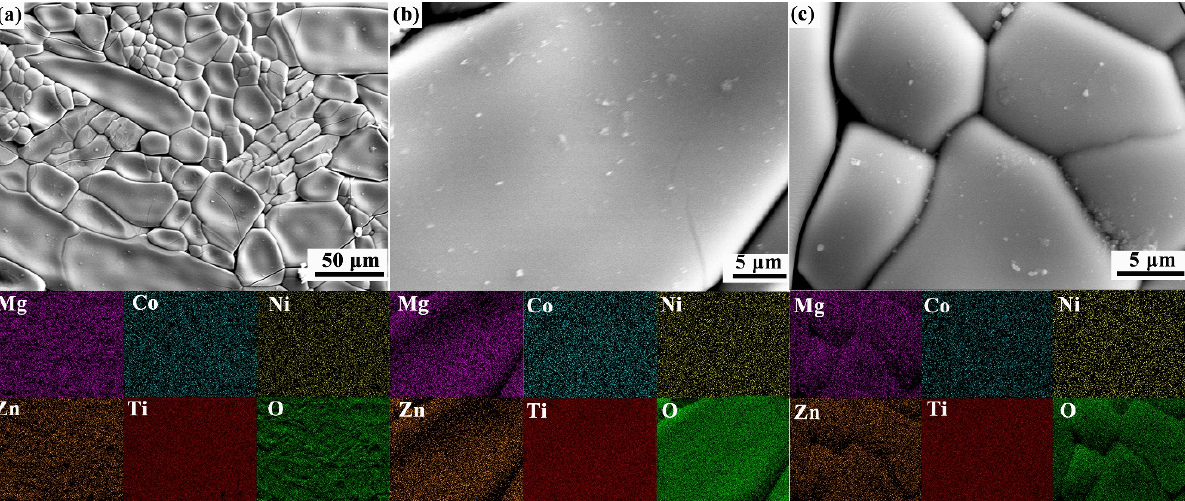
Fig. 4 (a) SEM image and corresponding EDS mappings of AT2; SEM images and corresponding EDS mappings of (b) abnormally large rod-shaped particles and (c) fine particles in AT2 after sintering at 1400 ℃